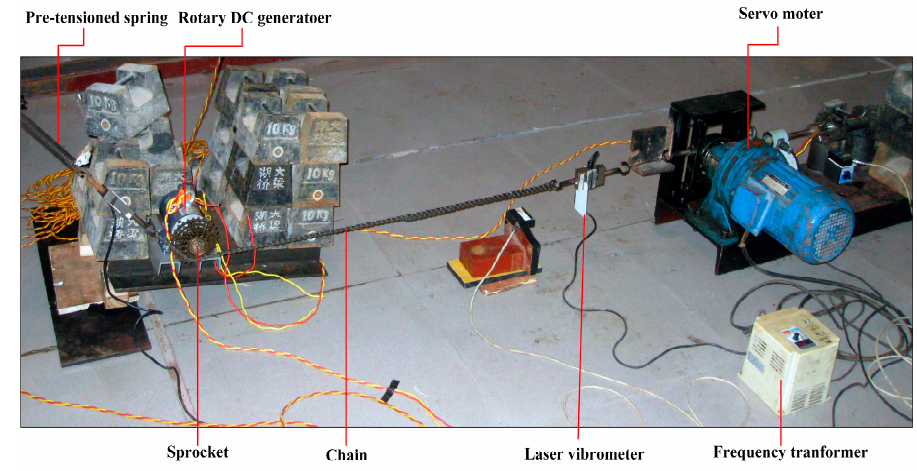
Figure 5. Experimental setup for the energy harvesting capability of the generator.